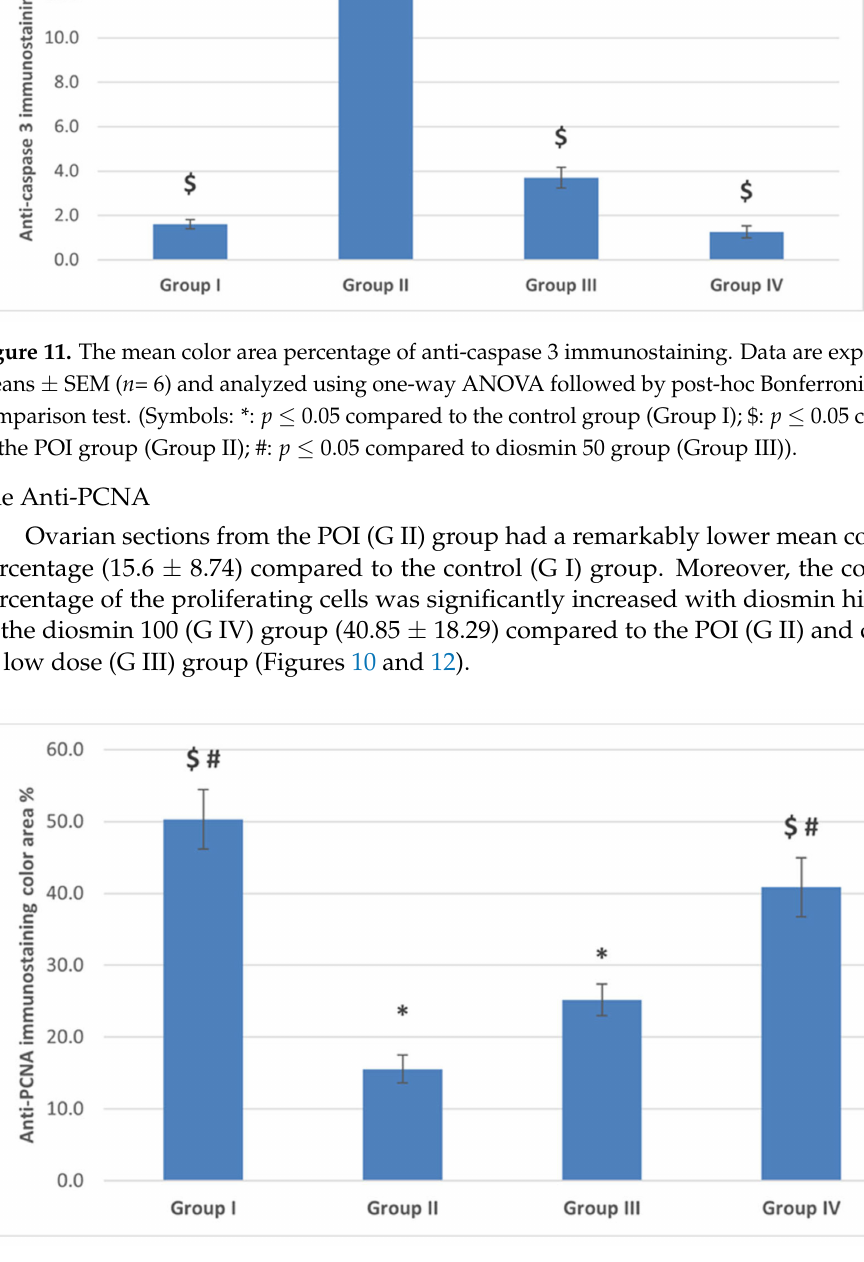
Figure 12. The mean color area percentage of PCNA immunostaining. Data are expressed as means ± SEM ( n = 6) and analyzed using one-way ANOVA followed by post-hoc Bonferroni multiple comparison test. (Symbols: *: p ≤ 0.05 compared to the control group (Group I); $: p ≤ 0.05 compared to the POI group (Group II); #: p ≤ 0.05 compared to diosmin 50 group (Group